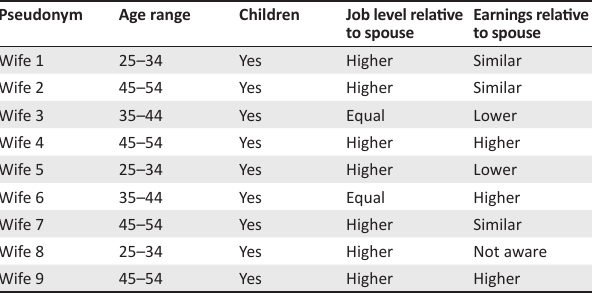
TABLE 1: Biographical summary of